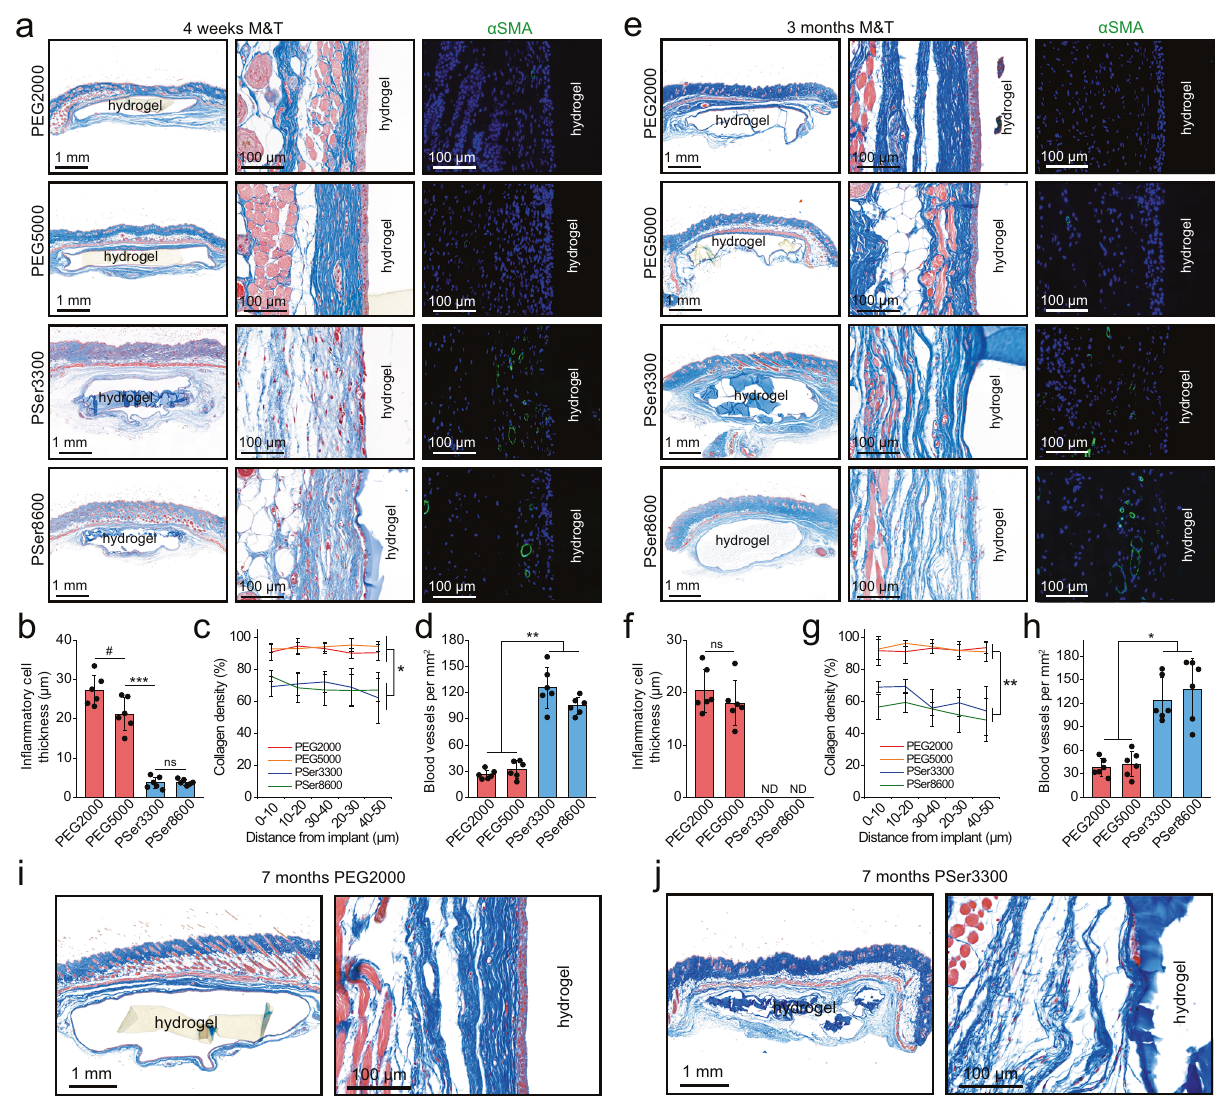
Fig. 4 Collagen and blood vessel density in tissues surrounding the PEG and PSer hydrogels 4 weeks and 3 months post subcutaneous implantation. a Masson ’ s trichrome (M&T) staining and α -smooth muscle actin ( α SMA) immuno fl uorescent staining to evaluate collagen encapsulation and blood vessels (green fl uorescence) density after 4 weeks of implantation. Nucleus were stained by DAPI to show blue fl uorescence. b – d Quanti fi ed data of in fl ammatory cell thickness ( b ), collagen density ( c ), and blood vessel density ( d ) ( n = 6, mean values± sd) of the hydrogel-tissue interface after 4 weeks of implantation. e M&T staining and α SMA immuno fl uorescent staining to evaluate collagen encapsulation and blood vessels (green fl uorescence) density after 3 months of implantation. Nucleus were stained by DAPI to show blue fl uorescence. f – h Quanti fi ed in fl ammatory cell thickness ( f ), collagen density ( g ), and blood vessel density ( h ) ( n = 6, mean values± s.d.) of the hydrogel-tissue interface after 3 months of implantation. ND represents not detected. i , j M&T staining of tissues surrounding PEG ( i ) and PSer ( j ) hydrogels after implantation for 7 months. Statistical analysis: one-way ANOVA with Tukey post- test, # p < 0.05, * p < 0.01, ** p < 0.001, *** p < 0.0001, ns: not signi fi